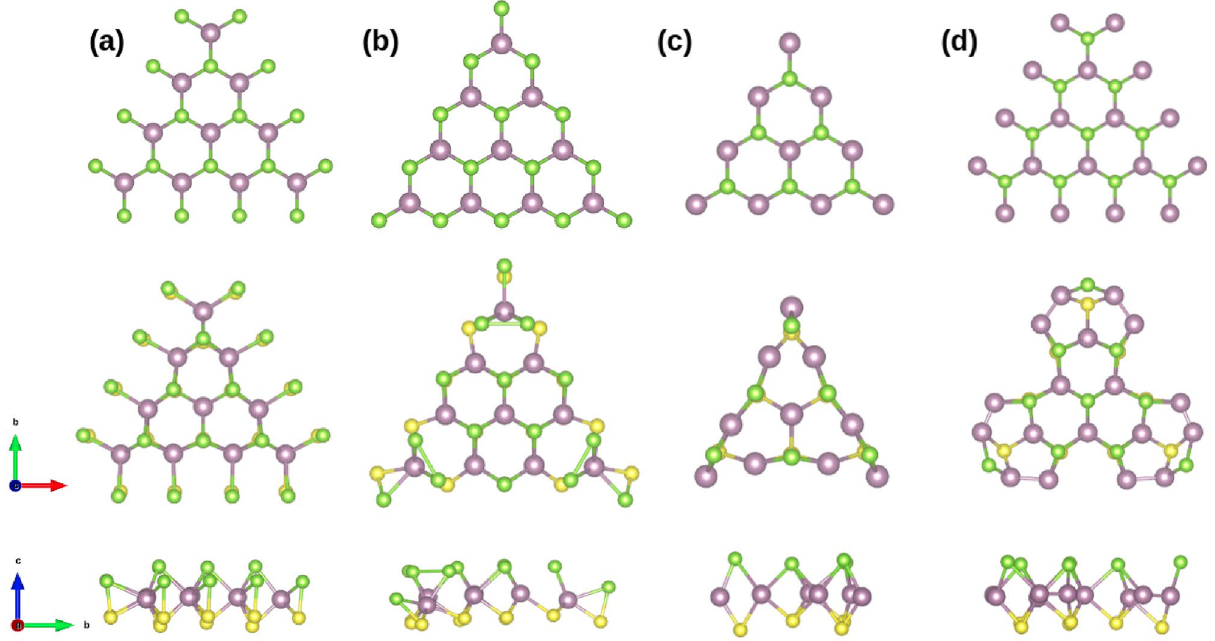
Figure 1. 1H-MoSSe quantum-dots obtained by the breaking of the ML in the low symmetry indexes direction. ¯ 10 ) ( a ) C1(4) from the ( 10 termination depicts Mo atoms in six-fold coordination where each Mo over the edge ¯ 1010 ) is bonded to a protruding S/Se dimer. ( b ) C2(4) from the ( termination, where the Mo atoms are also six- fold coordination. However, the Mo atoms from each edge are bonded with two S/Se dimers forming a zig-zag pattern. ( c ) C3(4) where S/Se atoms are three-fold coordinates with the Mo atoms forming a zig-zag edge with Mo exposed, and ( d ) C4(4) obtained from C1 exchanging Mo atoms with S/Se dimers. S, Se, and Mo atoms are depicted as yellow, green, and violet